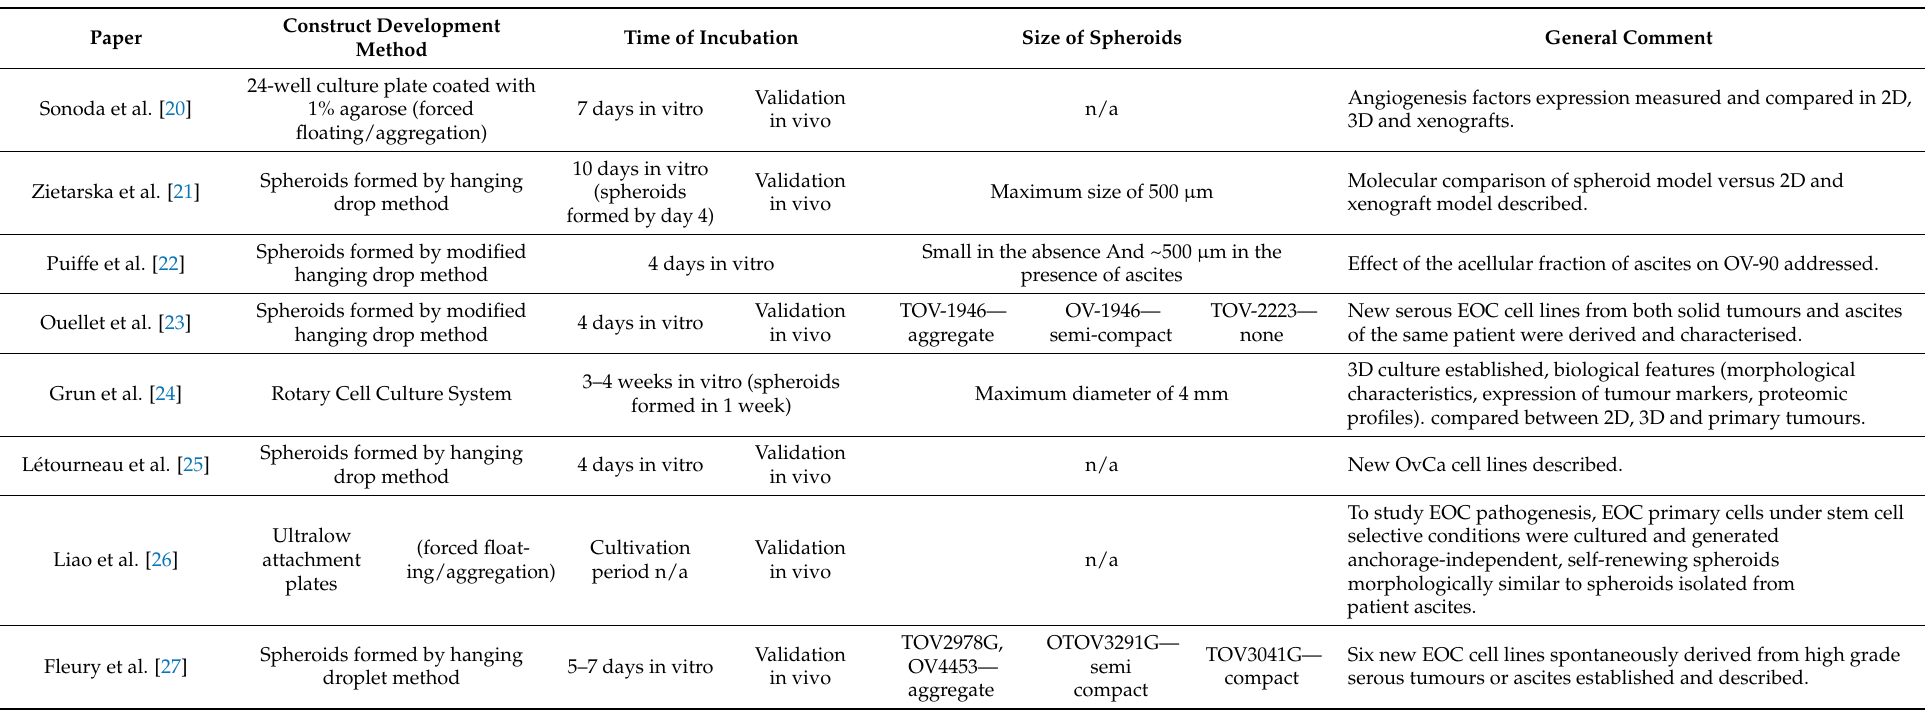
Table 6. Summary of papers, which used cell lines derived directly from primary patient specimens to develop spheroid models—part